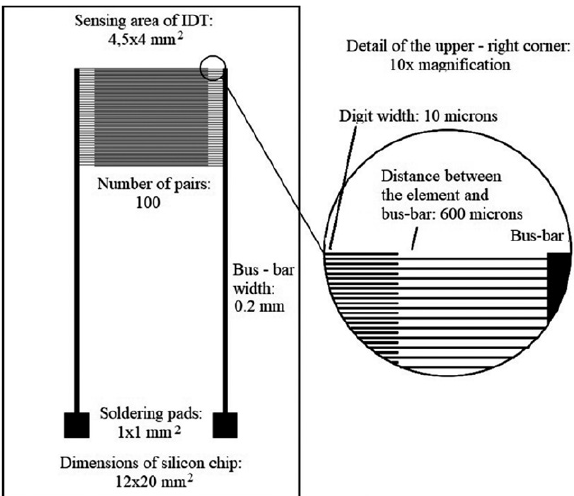
Figure 3. The metal stripes of IDT (Interdigitated